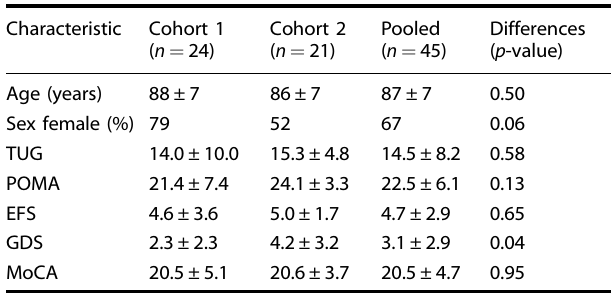
Fig. 4 Digital measure extraction fl owchart. Shows a broad summary of how digital measures were calculated, starting with raw sensor data from PIR sensors, door sensors, and bed sensors. Raw data streams were fi rst segmented into non-overlapping bi-weekly segments. Then, for each bi-weekly segment, digital measures were calculated. If, for a given measure, less than 10 days of data were present, the measure was encoded as missing, which eventually left 1268 dimensional vectors - one per bi-weekly segment. Table 4. Participant